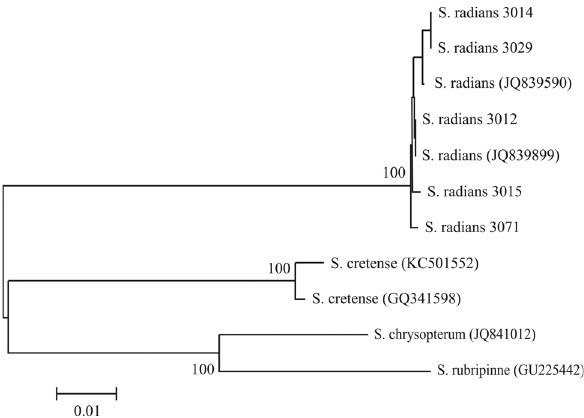
Figure 1 - Neighbor-Joining tree of COI sequences comparing S. radians from Brazilian coast and other populations and species of Sparisoma . The numbers in parentheses refer to GenBank database (see text for